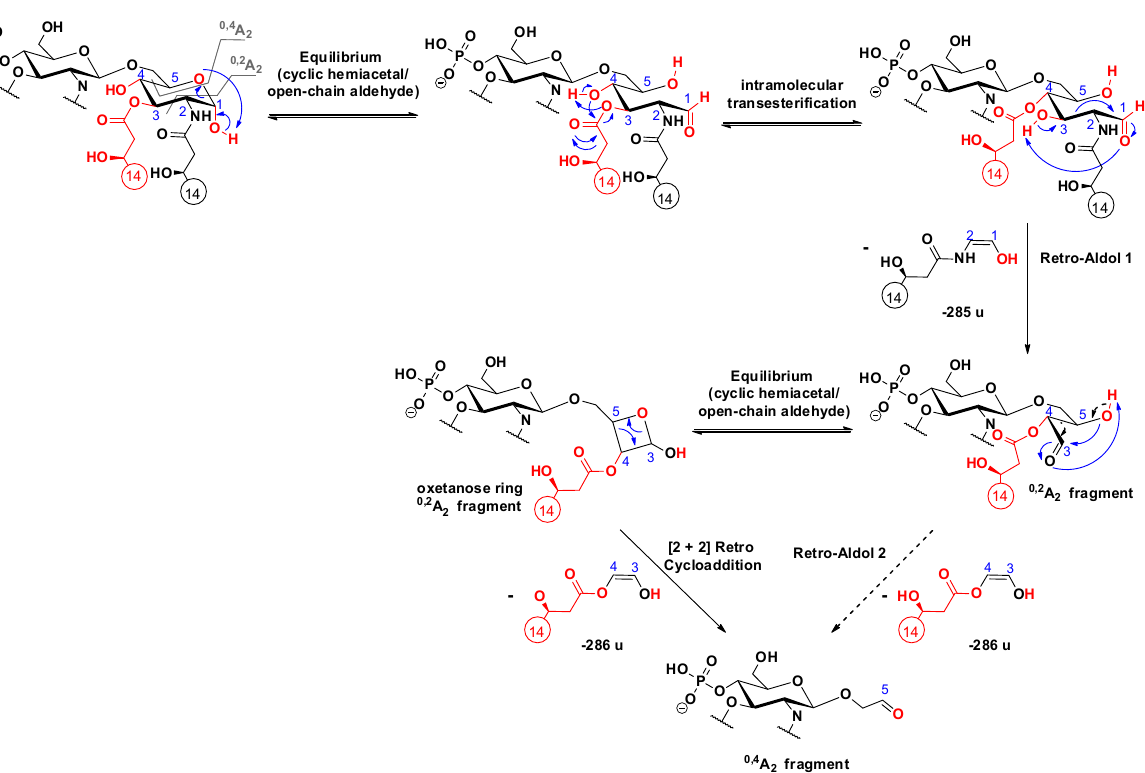
Scheme 13. Proposed mechanisms for the consecutive formation of 0,2 A 2 and 0,4 A 2 fragment ions in 3-acyl lipid A.